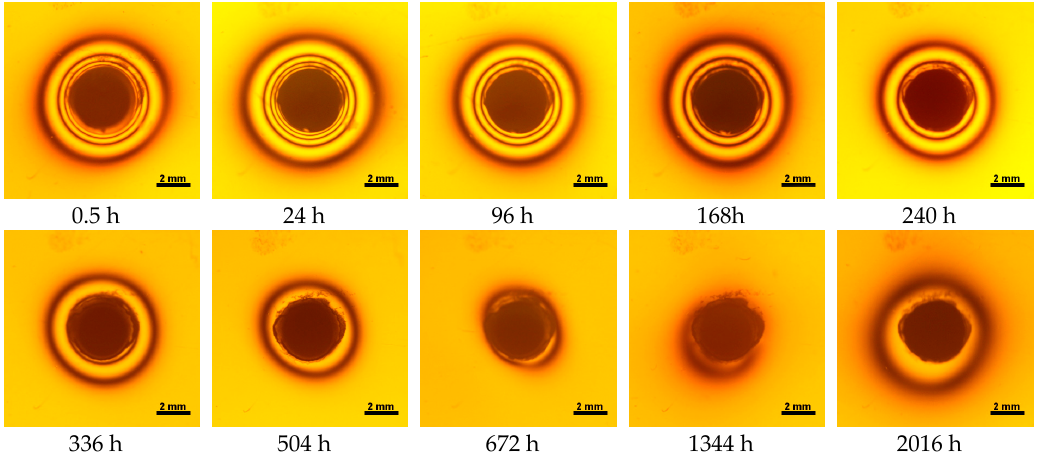
Figure 14. The influence of water sorption (2016 h water ageing) on the absorbency and contraction stress generated during the photopolymerization of SpeedCEM Plus.